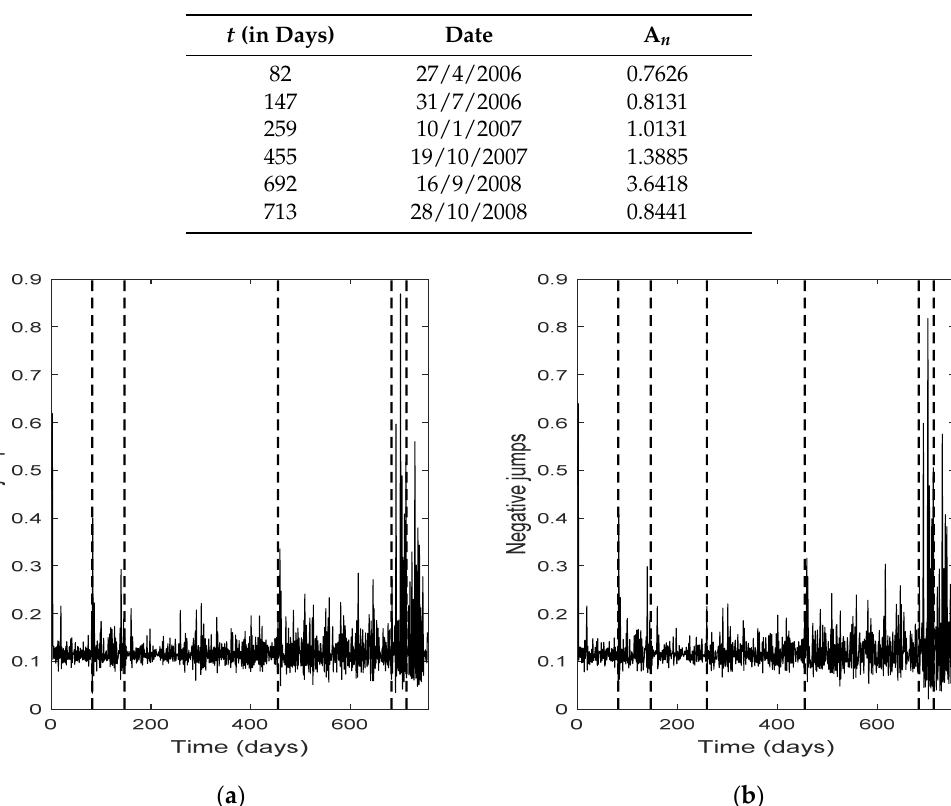
Table 20. Change points for the estimated negative jumps of Microsoft with the corresponding test statistic value.